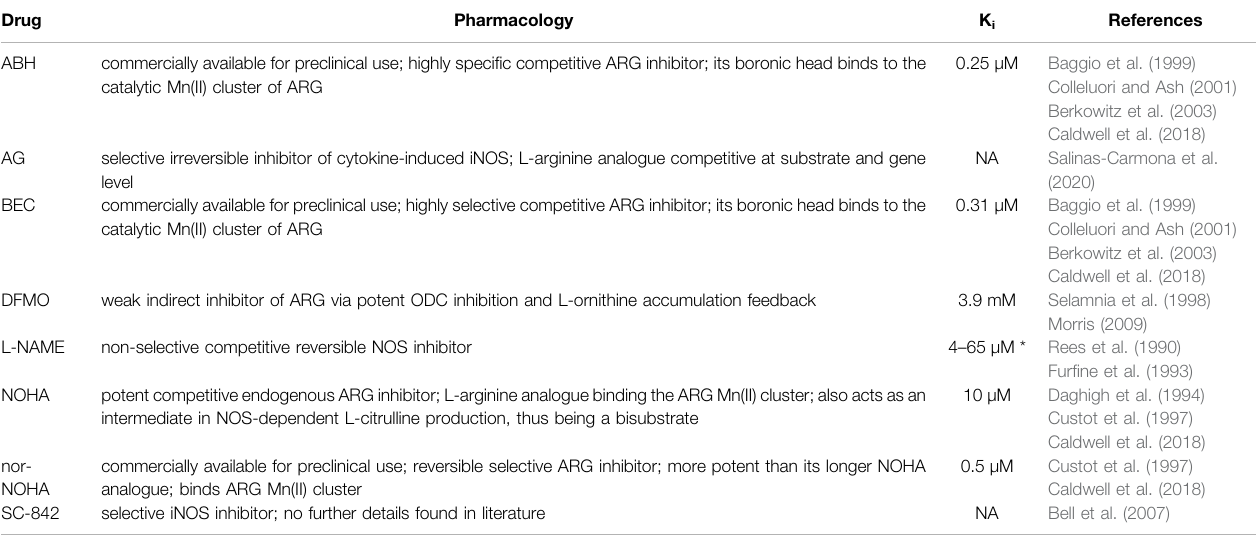
TABLE 2 | Summary of key ARG-pathway related drug pharmacodynamics. The inhibitory mechanisms of ARG pathway-targeting drugs are given together with their inhibition constants (Ki). * iNOS-speci fi c range. Drug